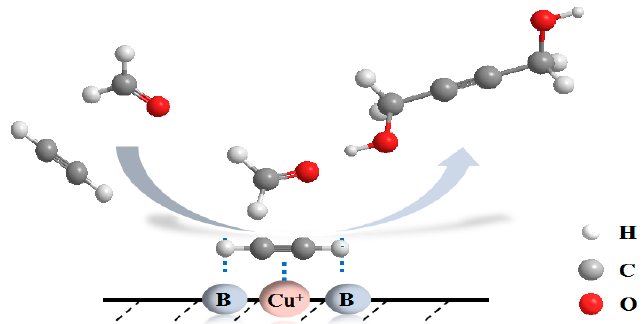
Figure 15. A plausible reaction mechanism on Cu 0.84 Mg 0.16 catalyst.